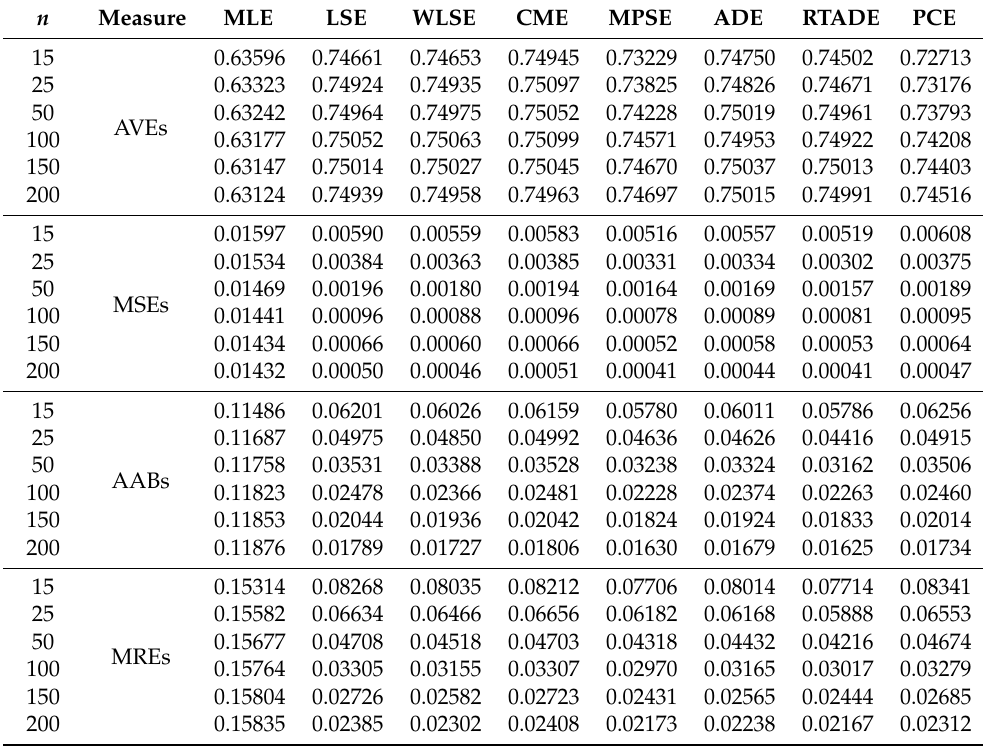
Table 5. Simulation results for the NDL distribution for θ = 0.75.